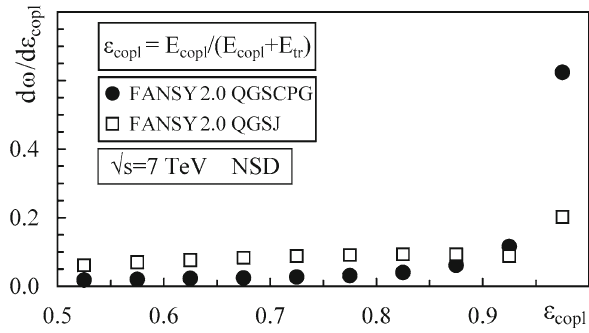
Fig. 10 Probability d ω/ d ε copl distributions predicted by FANSY